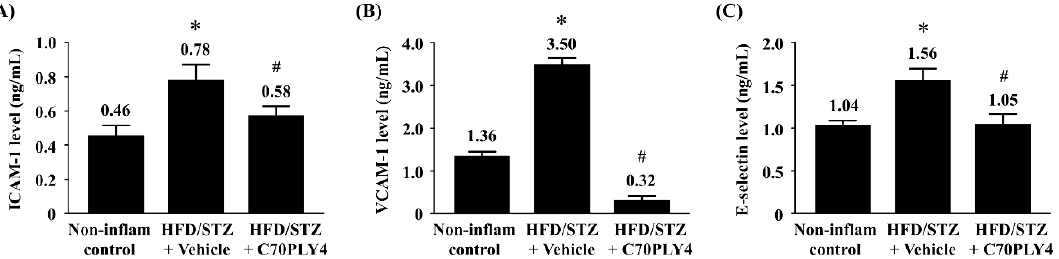
Figure 6. C70PLY4 inhibits the secretion of soluble ICAM-1, VCAM-1, and E-selectin in STZ-injected HFD-fed rats. The rats were divided into three groups as follows: control rats (Non-inflammatory control), inflammatory rats (HFD / STZ + vehicle), and inflammatory rats administered with C70PLY4 (HFD / STZ + C70PLY4). The secretion of ( A ) soluble ICAM-1, ( B ) soluble VCAM-1, and ( C ) soluble E-selectin in the serum was determined. Data are the mean ± SEM from three independent experiments. *, p < 0.05 vs. non-DM control. #, p < 0.05 vs. STZ-treated rats.